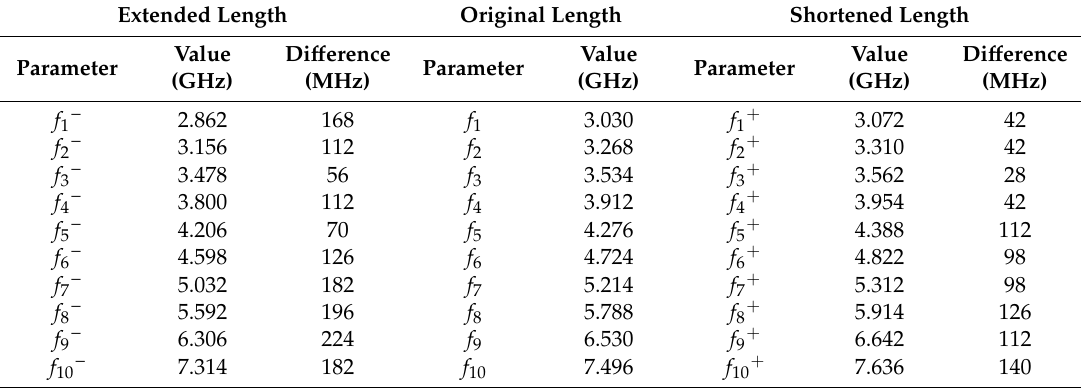
Figure 12. Simulated values of the simulation reflection coefficients (S 11 ) for the M-strips resonators with length variations. Table 4. Corresponding frequencies for the M-strip resonators with length variations.